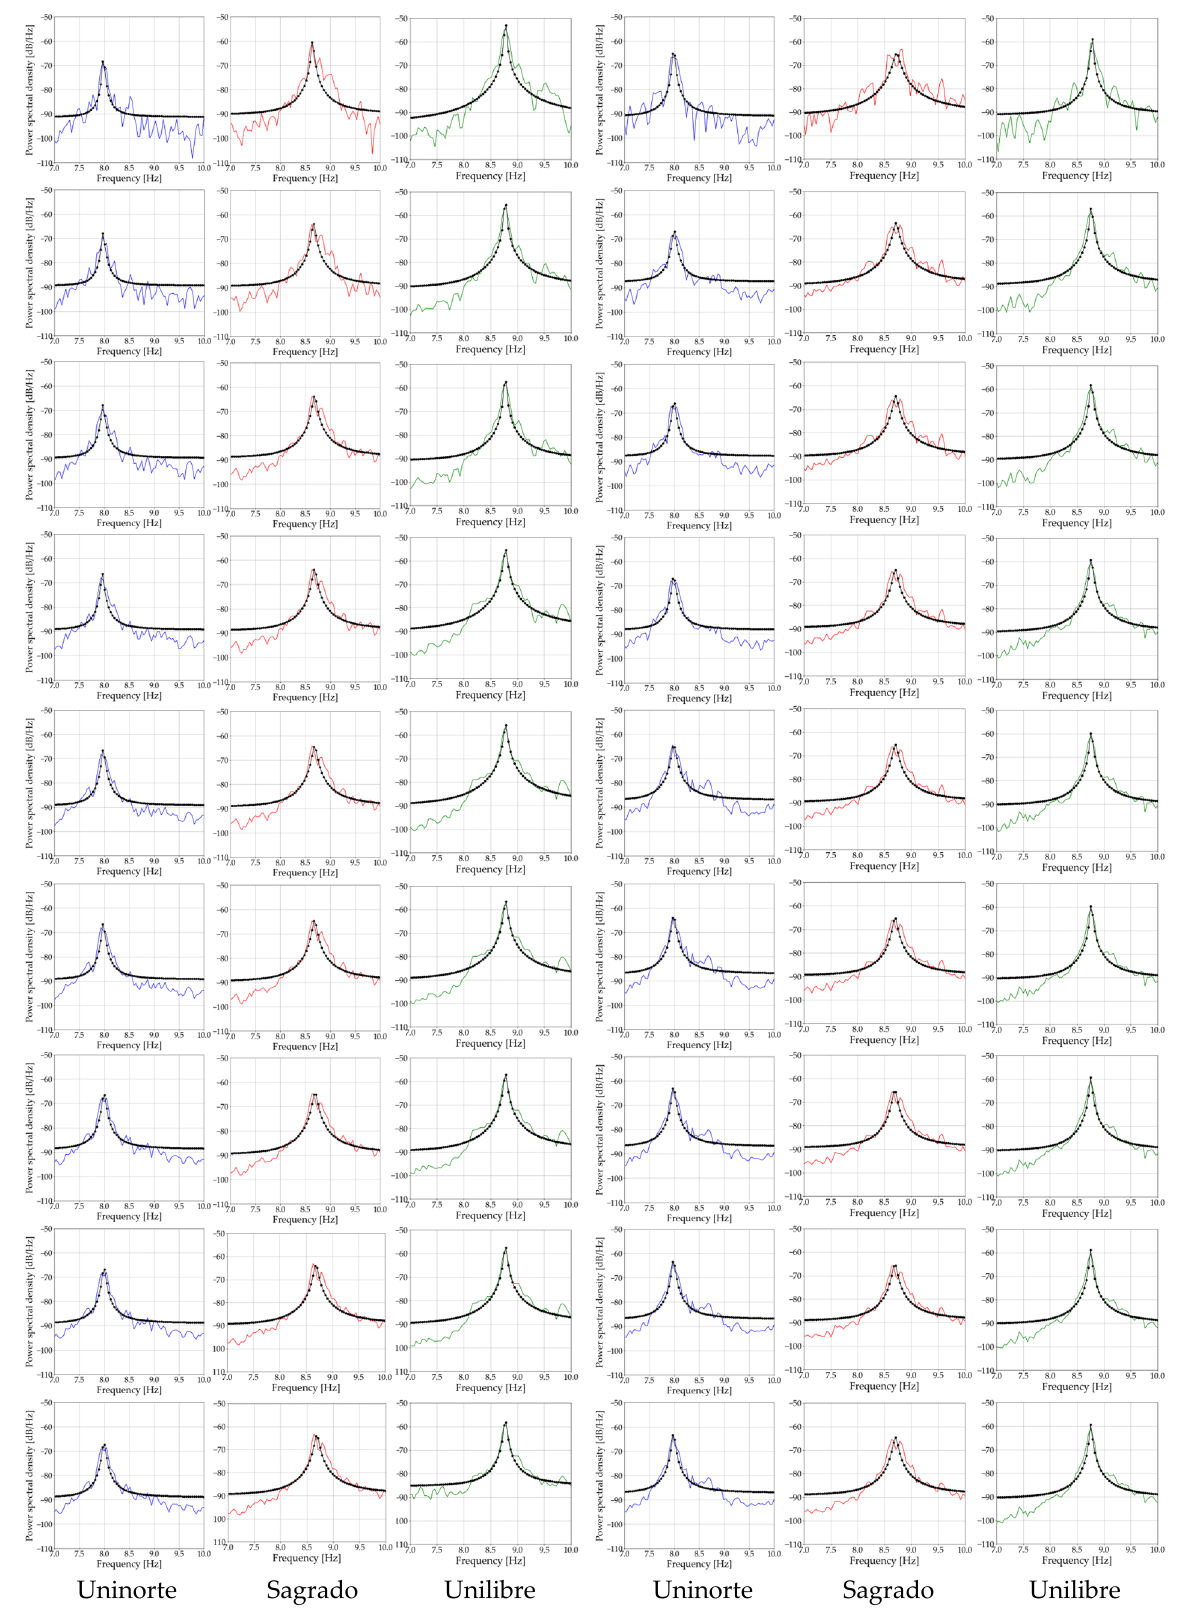
Figure 20. Curve fitting of experimental PSD for the observations in each bridge.